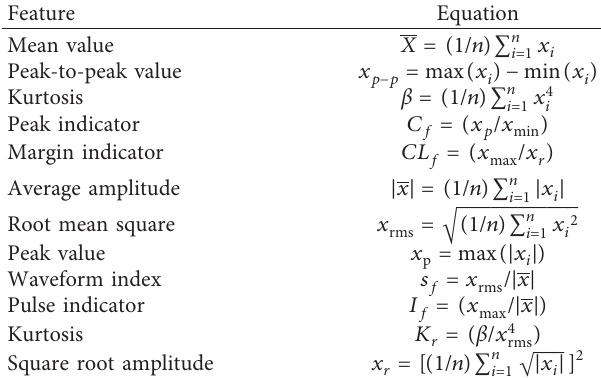
Table 1: Alternative performance degradation